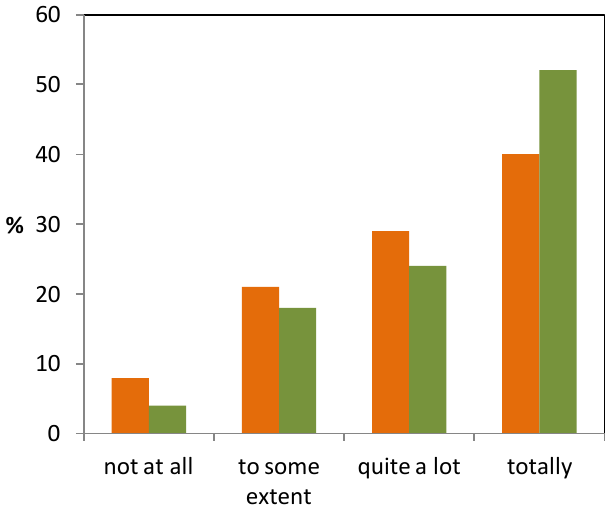
Figure 7. Perceptions of the extent to which the TB is influenced by the forest